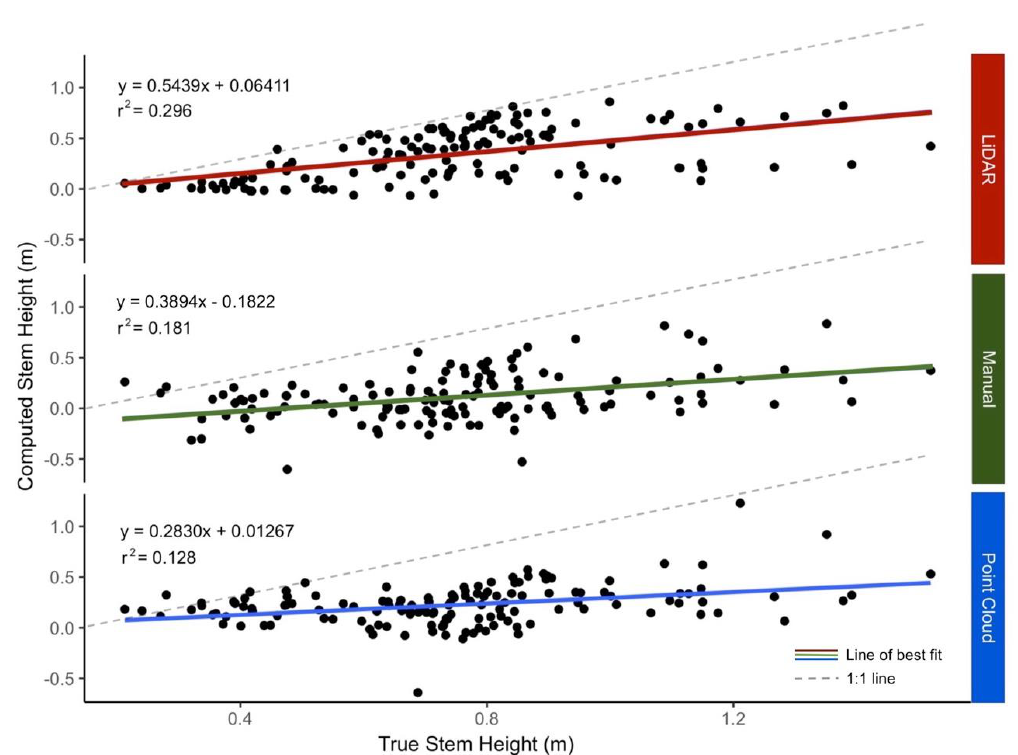
Figure 4. Computed vs. true regression mapped vegetation height derived from UAS imagery to field-measured true stem heights. The 1:1 line, where computed stem height is equal to true stem height, is displayed for reference. Computed vegetation heights are compared across the point cloud, manual, and Light Detection and Ranging (LiDAR)-derived digital terrain models.